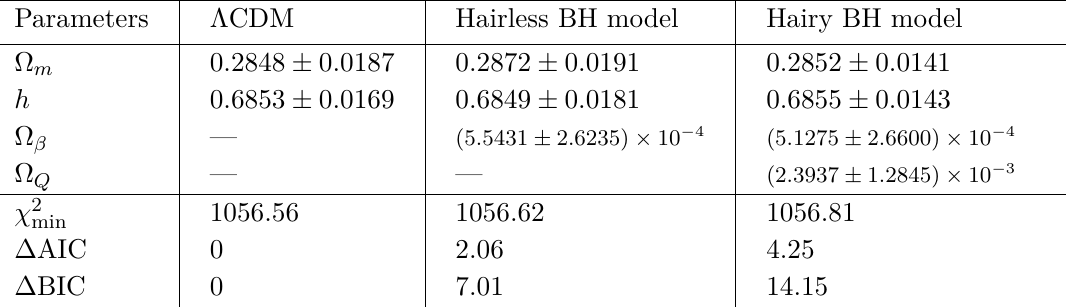
Table 1 . The best-fit values of cosmological parameters and their uncertainties with 68.3% C.L.